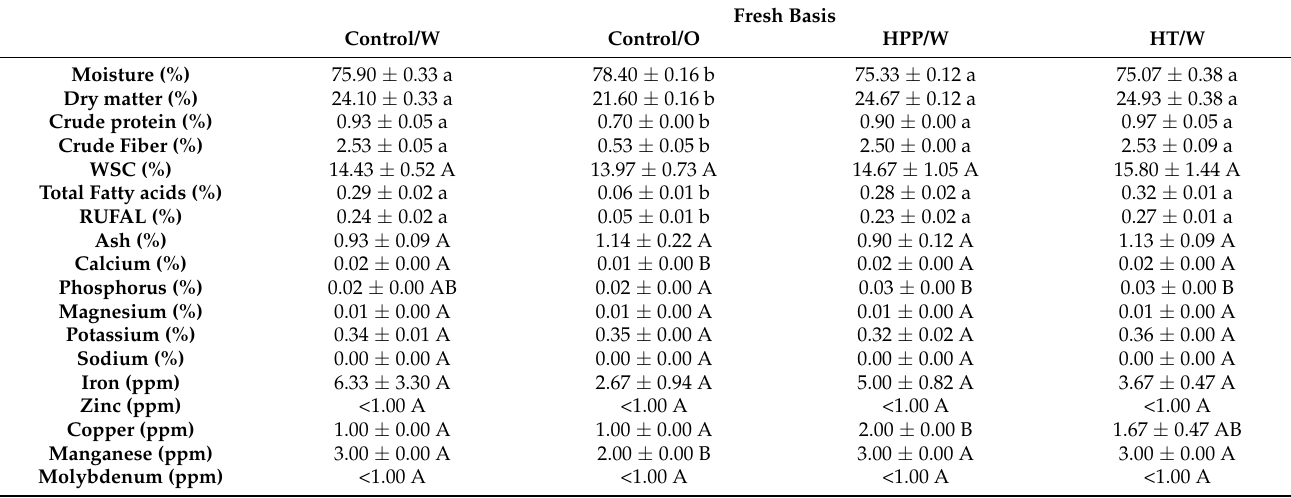
Different uppercase letters indicate significant differences among different treatments ( p < 0.05); different lowercase letters indicate significant differences among different treatments ( p < 0.001). Control/O: untreated samples without seeds; Control/W: untreated samples with seeds; HPP/W: HPP-treated (600 MPa, 3 min) samples with seeds; HT/W: HT-treated (63 ◦ C, 3 min) samples with seeds; WSC: water-soluble carbohydrate; TFA: total fatty acids; RUFAL: rumen unsaturated fatty acids.